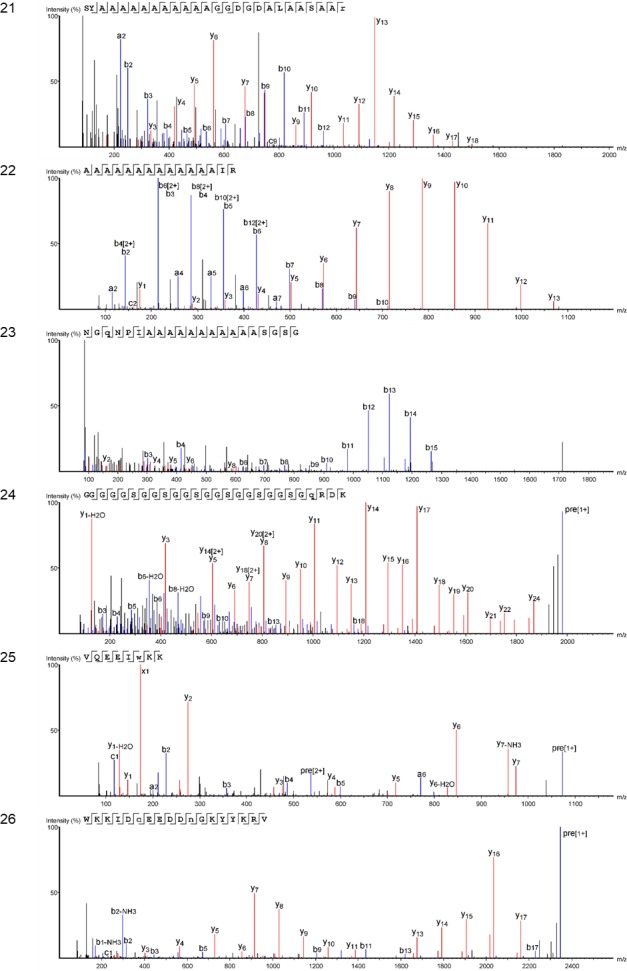
Product ion spectra [21 - 26] supporting the coverage of protein Hic74 identified in the double-button HavC.